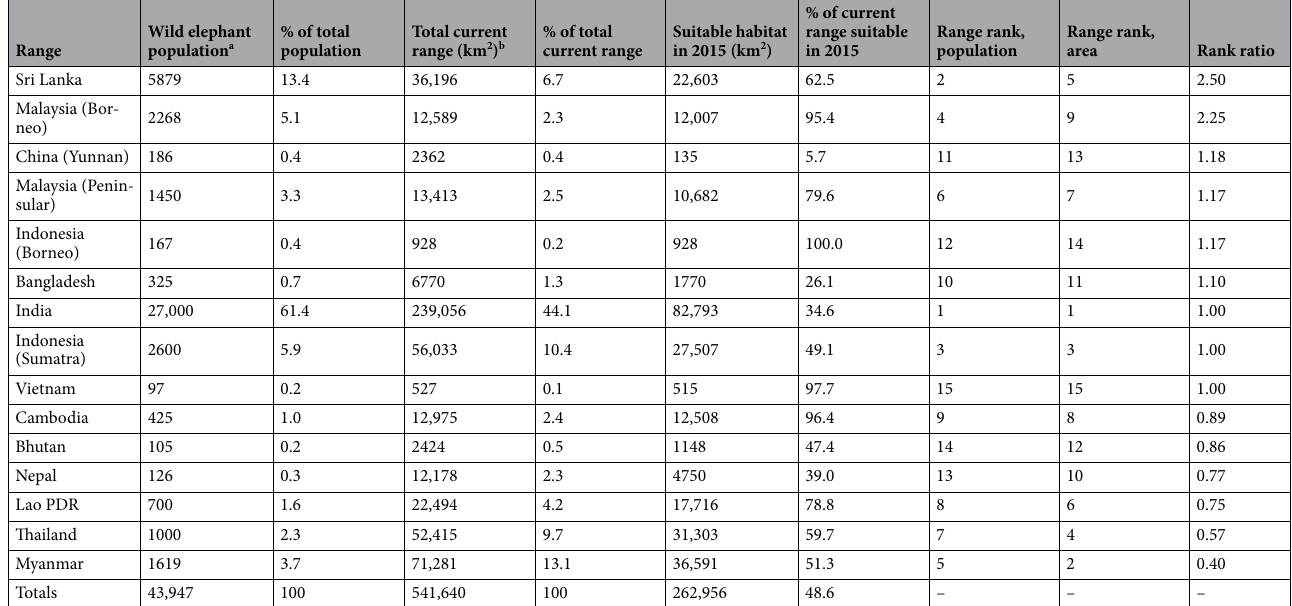
Table 3. Elephant population sizes relative to available range. “Total current range” refers to the extent of range in which elephants were thought to be present in the 2000s. “Current Range Suitable in 2015” refers to the amount of this current range still classified as suitable habitat by the year 2015 under the LUH2 model. Ranges are ranked by the percentage of the global elephant population found within them as well as the percentage of global range they encompass (for China, this is limited to Yunnan province only). They are ordered by rank ratio, which is the area rank (based on % of total current range) divided by the population rank (based on % of total population). A ratio close to 1 indicates that the population size is proportional to the share of the current range within that region, higher ratios indicate populations are larger than expected on